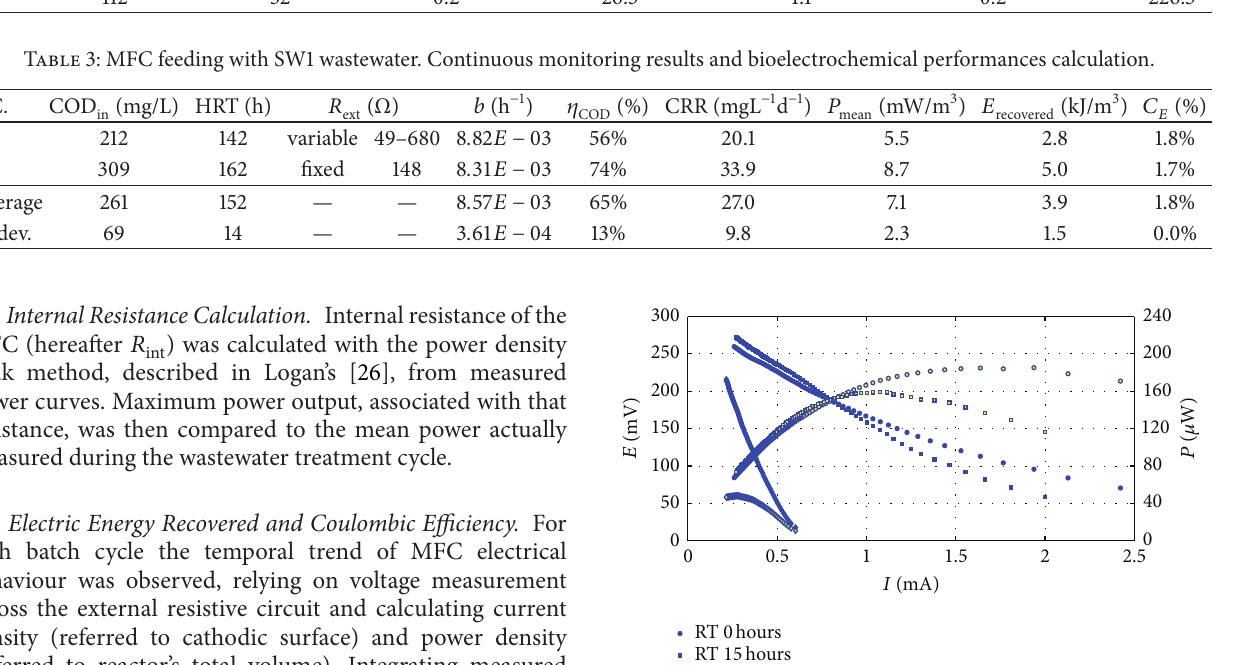
Figure 3: Electrodes polarization during treatment cycle 1. Filled